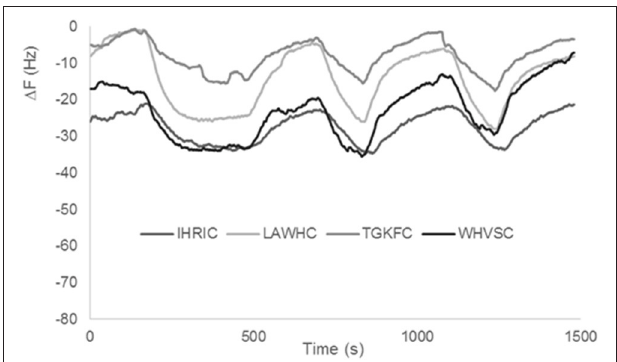
FIGURE 5 | (A) The biplot values (sores and loadings) for fruit juices analysis along with the percentage (B) of fruit quantity and sugar concentration in the different fruit juices.